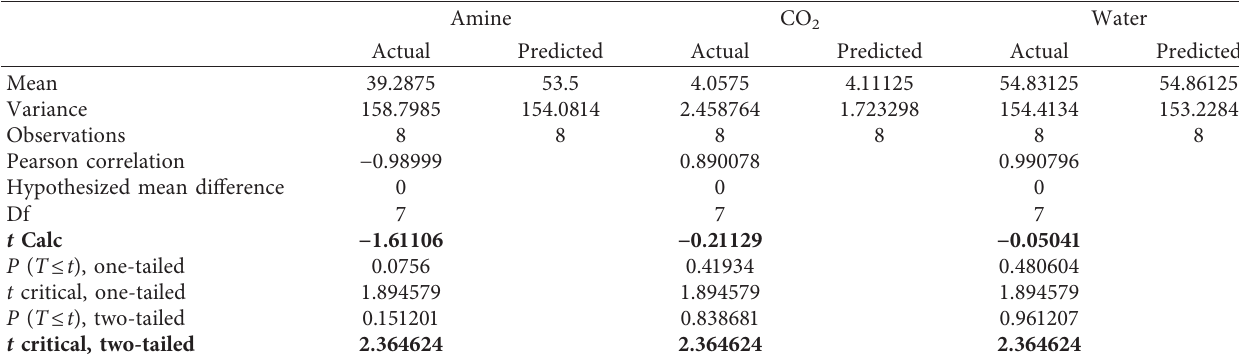
Table 3: Difference between the actual and predicted values for validation sample evaluated using t -test (paired two sample for means). Amine